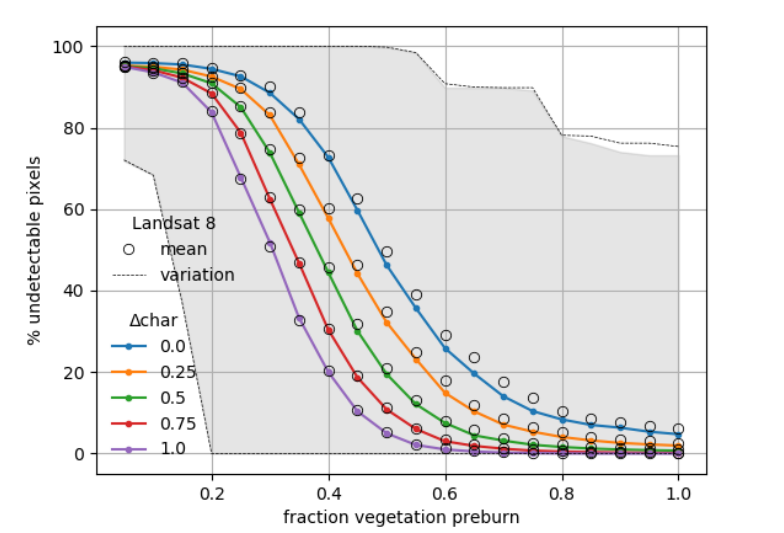
Figure A15. Percentage of undetectable pixels as a function of starting vegetation fraction and ∆ char parameter setting, park-wide for the Moderate Resolution Imaging Spectroradiometer (MODIS), dNBR threshold = 0.15. Mean values are shown in colored lines, with total model result variation shown in gray. To compare, the results for Landsat 8 are shown in black, with mean values shown by circles and total model result variation shown by dashed lines.